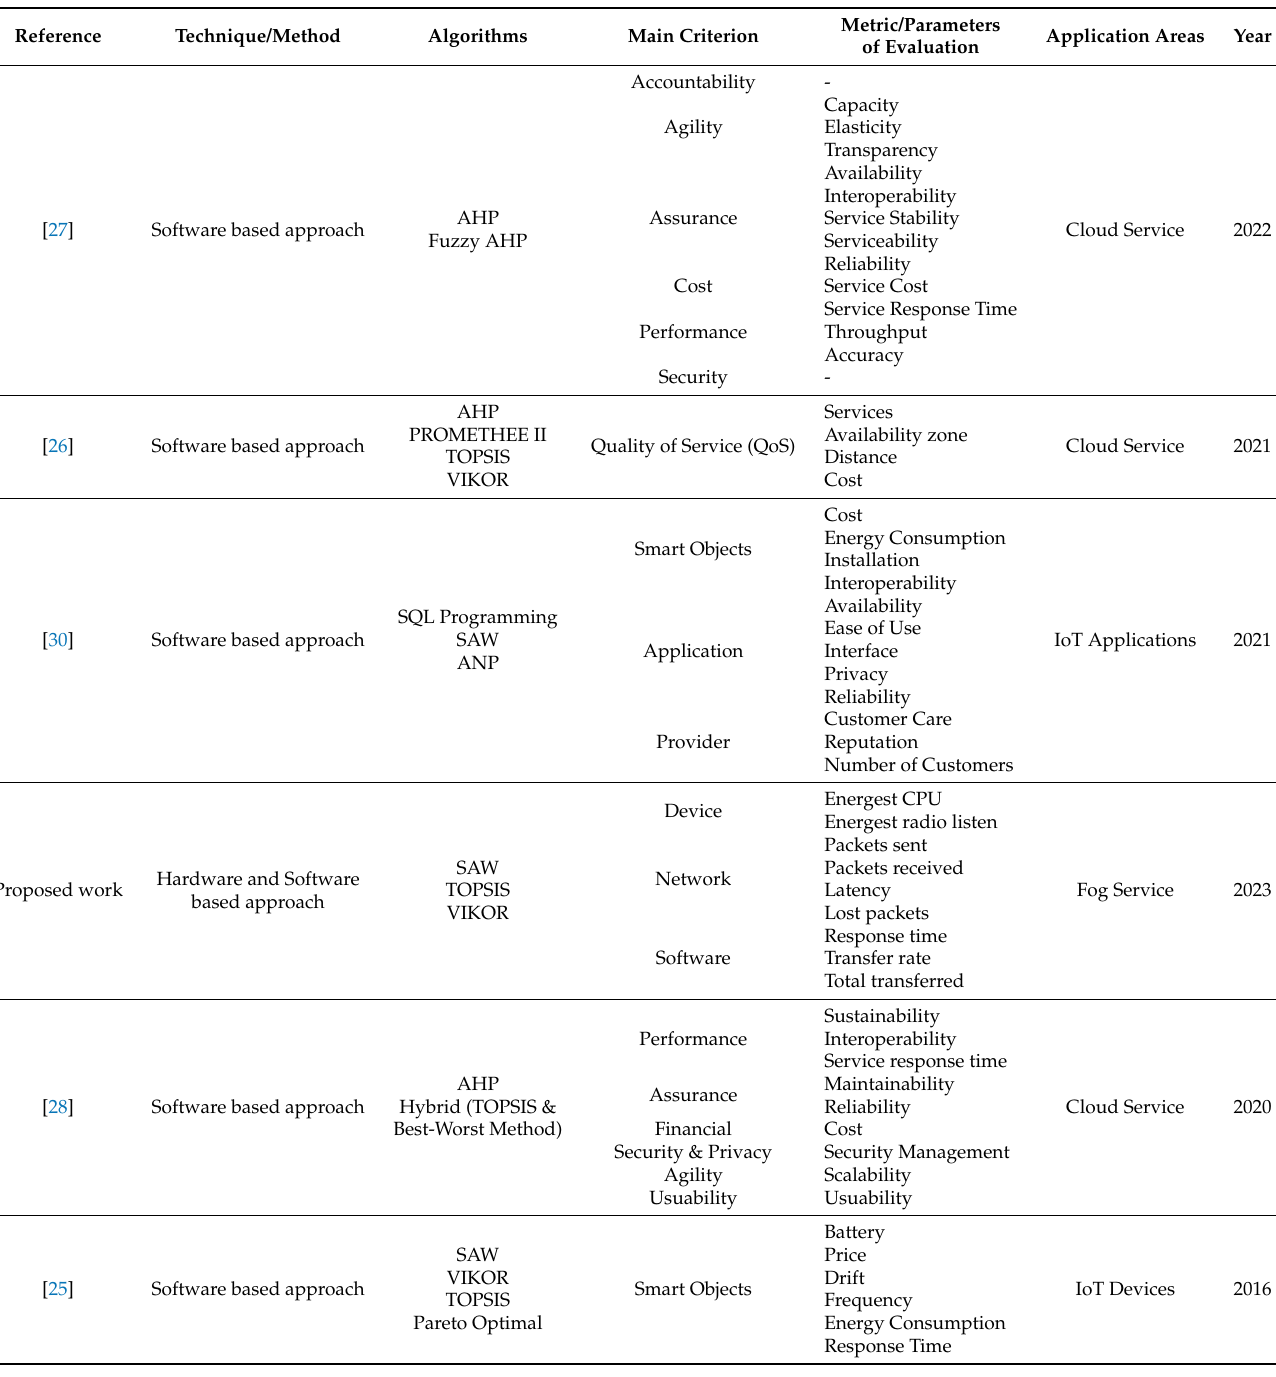
Table 1. Summary of studies taken under